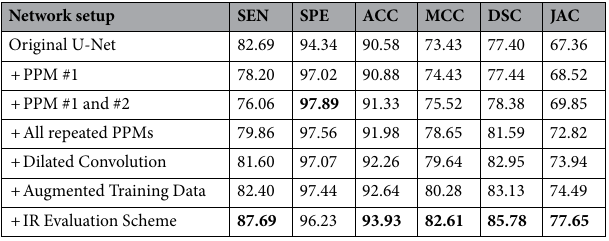
Table 2. Evaluations of different network’s component